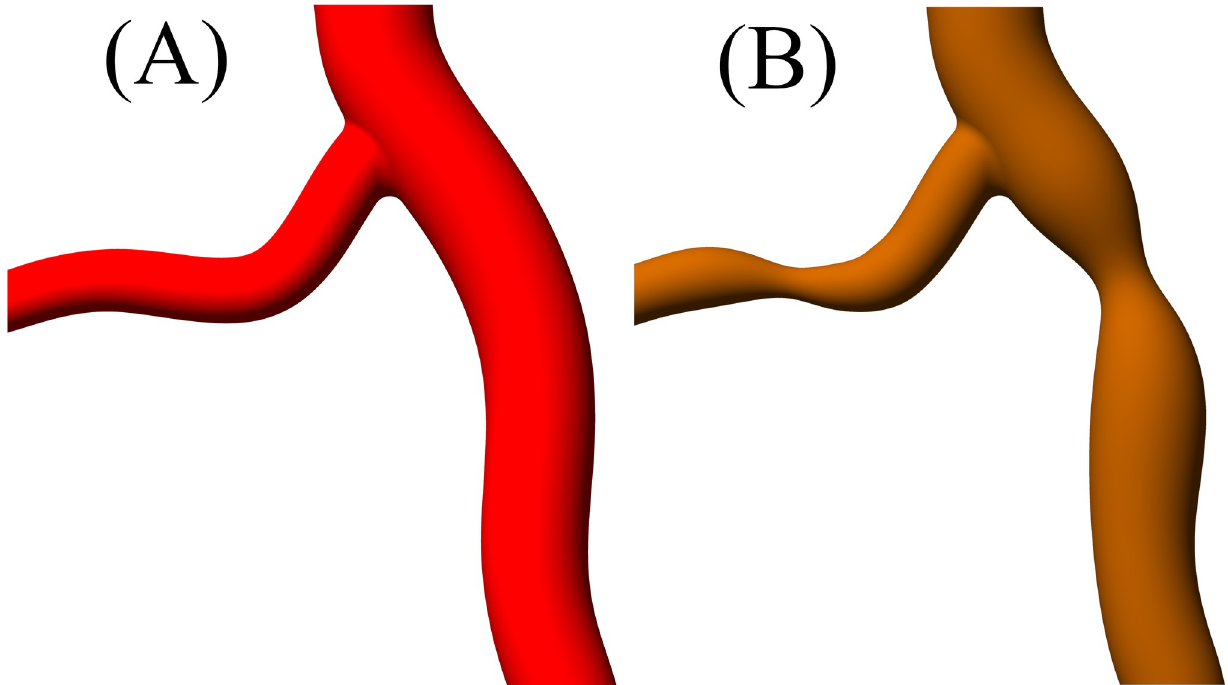
Fig 2. Comparison between (A) healthy and (B) diseased arterial bifurcation with